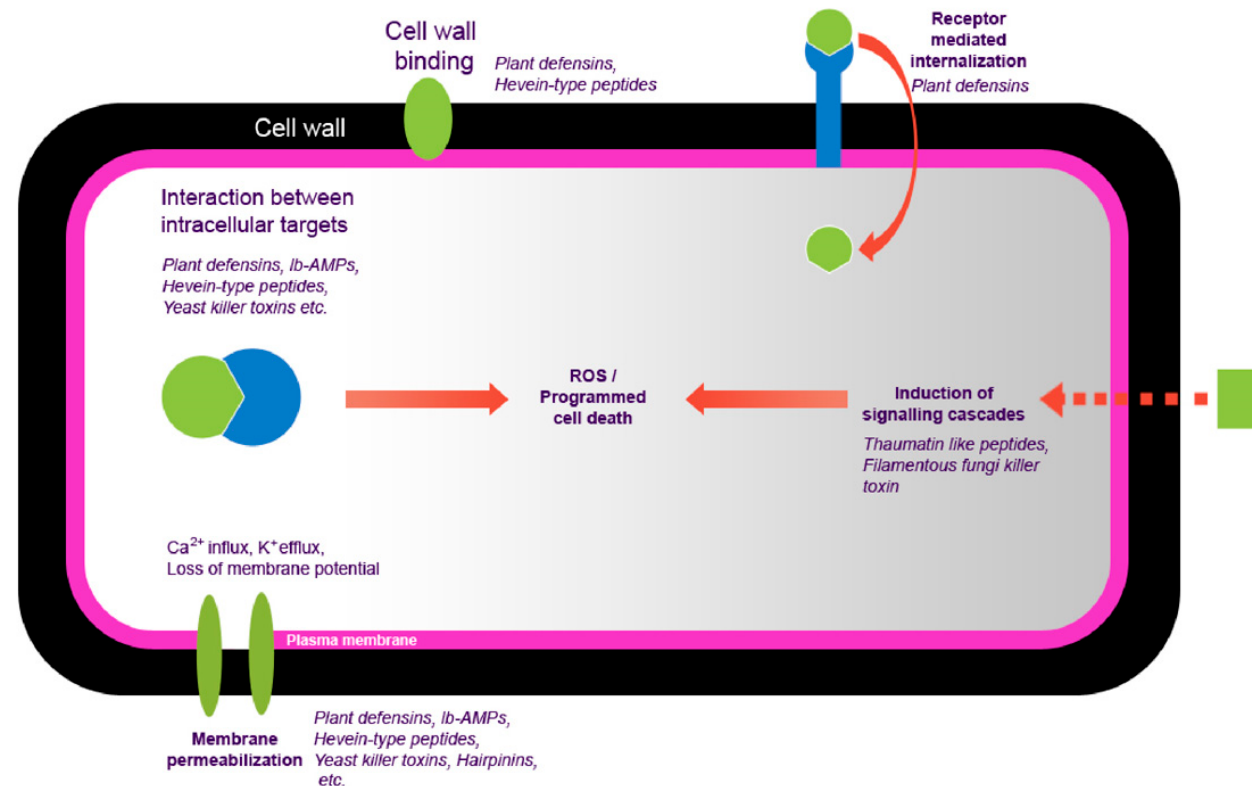
Figure 1. The mechanism of action of plant-derived antifungal peptides. Due to a higher stage of development of peptide ‐ based therapeutics, pharmaceutical companies focus more on peptide ‐ based drugs [19]. A large number of calculation tools, such as AntiCP [20], ToxinPred [21], TumorHPD [22], AVPpred [23] and CellPPD [24] have peptides, antiviral peptides, and cell-penetrating peptides, respectively. We extracted 510 experimentally validated, manually curated peptides from the PlantAFP database for SVM learning. We have not included modified or non-natural amino acids in our studies. We collected 510 random peptides from the UniProt database and considered them as a negative dataset. Thus, the PhytoAFP main dataset contains 510 PhytoAFP and 510 Non-PhytoAFP. In this case, positive refers to antifungal peptides, whilst negative refers to non-antifungal peptides. The architecture of our current work is provided in Figure